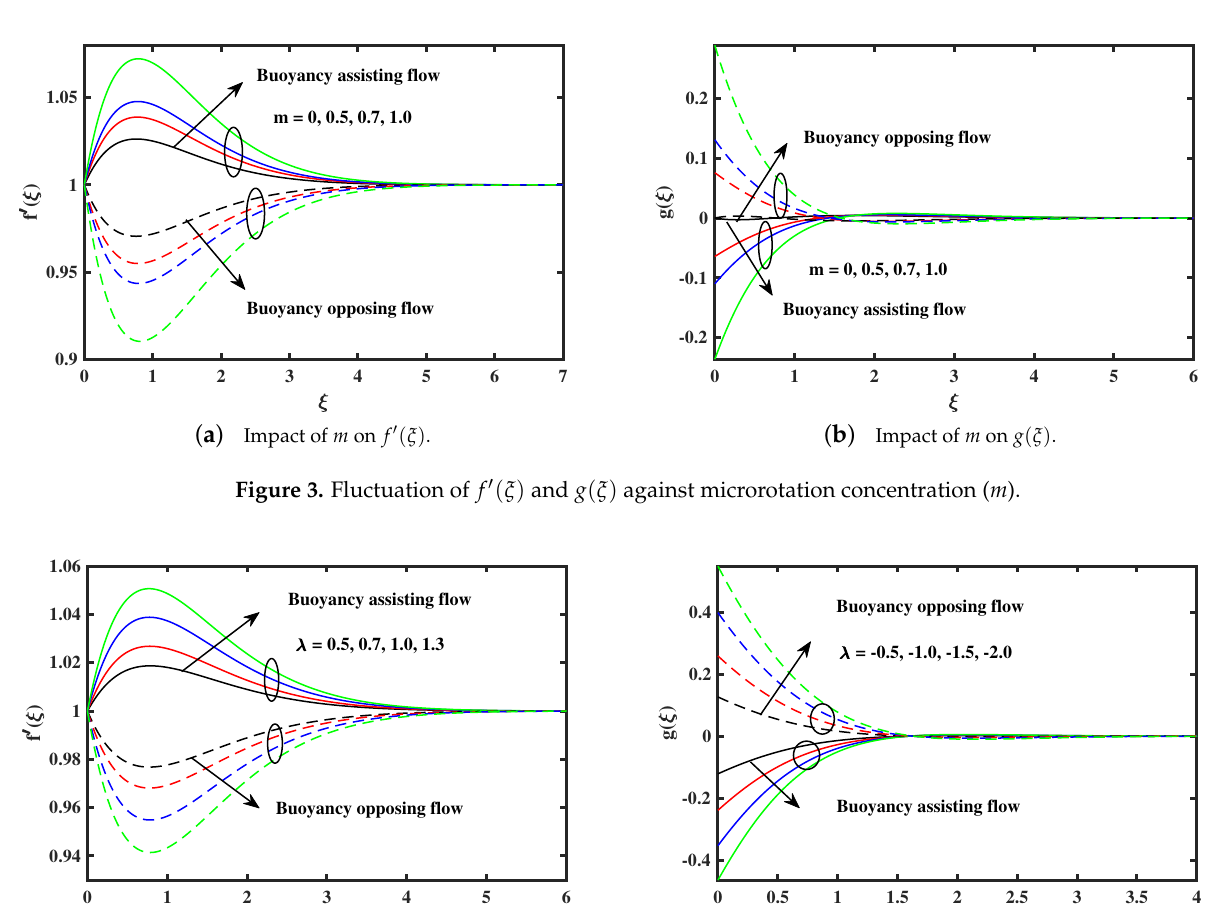
Figure 2. Fluctuation of f (cid:48) ( ξ ) and g ( ξ ) against injection/suction ( f w ).